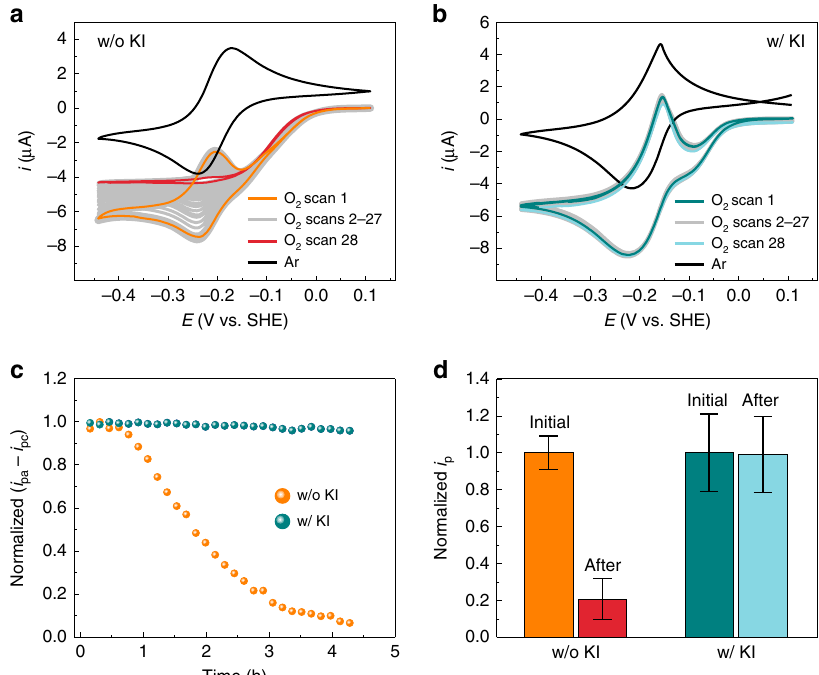
Fig. 3 Electrochemical study of the viologen-modi fi ed fi lm degradation. Cyclic voltammograms (CVs, 28 cycles) of viologen-modi fi ed hydrogel fi lms on glassy carbon electrodes (GCE) under 5% O 2 in argon a in the absence and b in the presence of KI (0.1M). CVs recorded under 100% argon are shown as black curves. c Normalized peak current amplitudes (anodic peak current ( i pa ) − cathodic peak current ( i pc )) extracted from the reversible redox signals of the viologens overlapping with the catalytic wave for O 2 reduction derived from the measurements shown in a and b . d Normalized peak current ( i p ) before and after O 2 reduction derived from CVs under 100% argon (Supplementary Fig. 8). Error bars are de fi ned as standard deviation. Average values and standard deviations were obtained from measurements at three individually prepared electrodes and then normalized by average i p values before O 2 reduction. All measurements were performed with GCE (3mm in diameter) coated with viologen-modi fi ed polymer with a surface coverage of 0.3mgcm − 2 . Electrolyte: phosphate buffer (0.1 M, pH 7). Scan rate: 2 mVs − 1 . Rotation rate: 2000r.p.m. Source data are provided as a Source Data fi